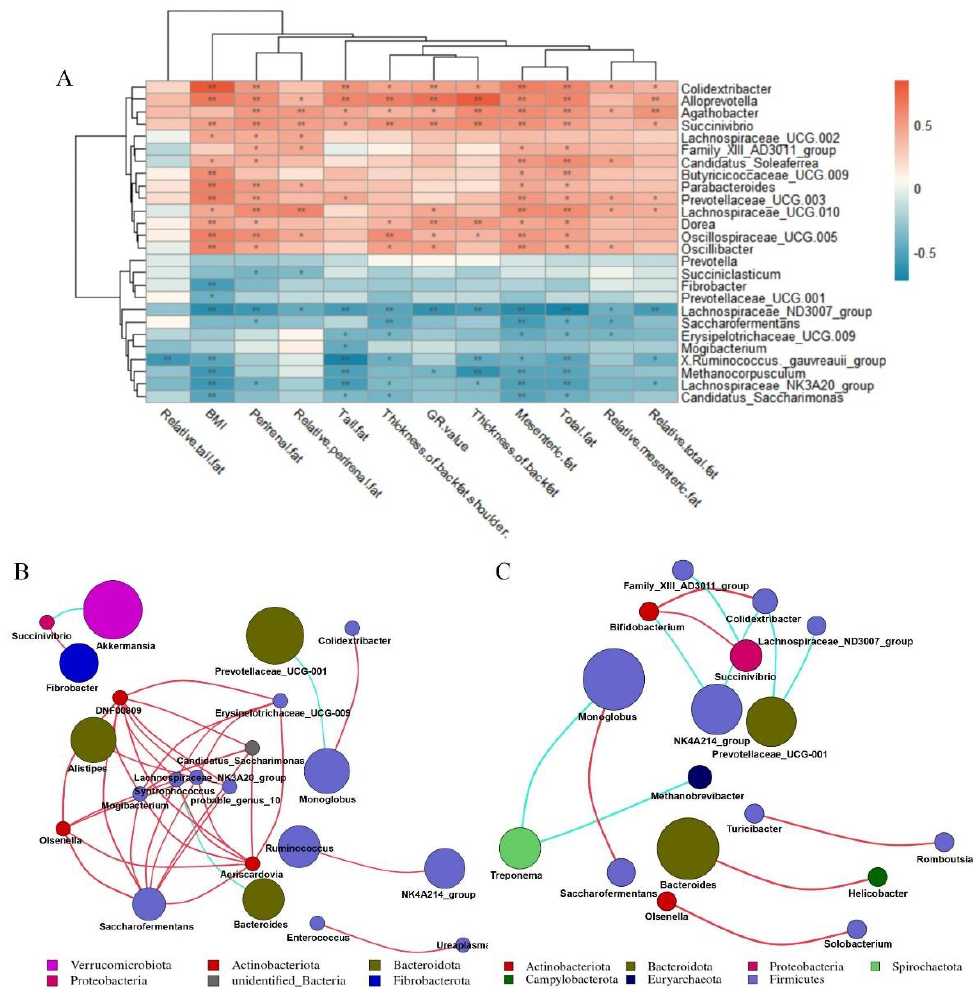
Figure 5. Correlation analysis. Correlation network analysis diagram constructed according to annotation results. Correlation network deduced from the first 50 genera. Each point represents a genus, and the size of the point is directly proportional to the relative abundance of the genus. Lines between points indicate correlation relationship between genera: red is positive correlation, blue is negative correlation, and only lines with correlation greater than 0.6 are displayed. ( A ) Correlation analysis between cecal differential microorganisms and fat deposition traits of Hu sheep. *, p < 0.05; **, p < 0.01. ( B ) Correlation network diagram of genus-level microorganisms in cecum of low-BMI Hu sheep group. ( C ) Correlation network diagram of genus-level microorganisms in cecum of high-BMI Hu sheep